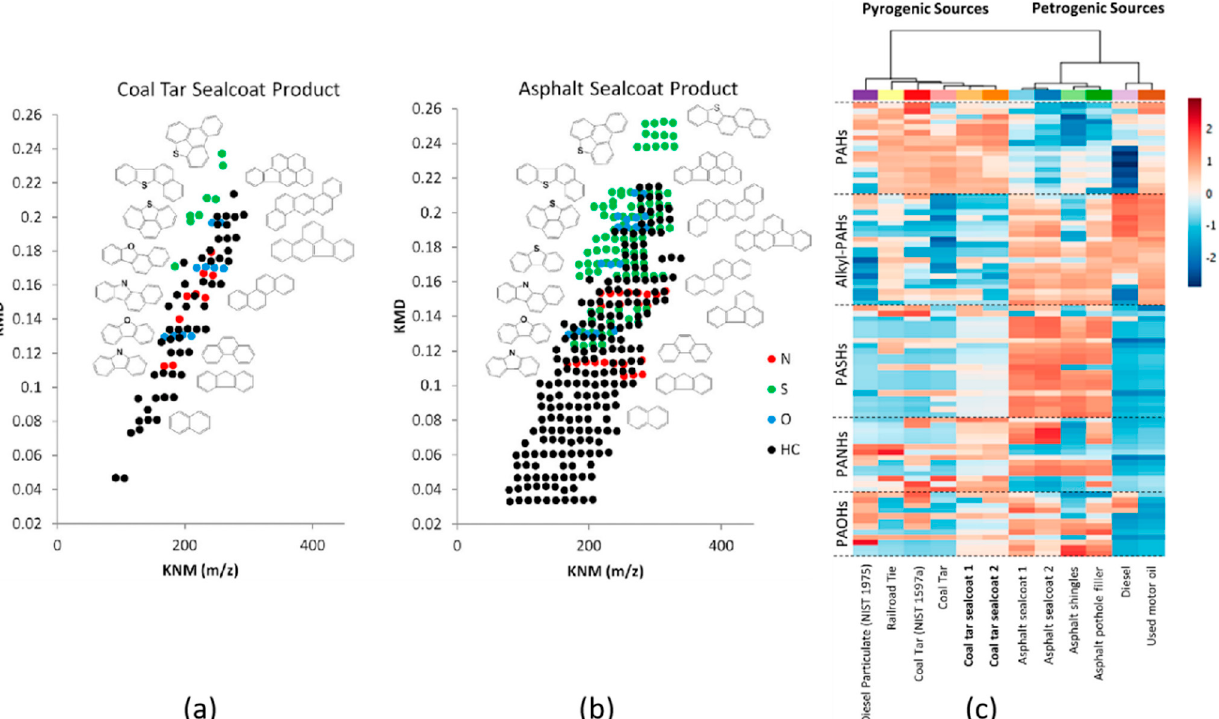
Figure 3. Kendrick mass defect (KMD) plots of ( a ) a coal tar sealcoat product, and ( b ) an asphalt sealcoat product. ( c ) Two-dimensional hierarchical cluster analysis with heat map plot of various environmental PAH sources. The colors red and blue represent the most intense and least intense relative abundance values (log scale). The relative abundances in the heat map plot are presented as an average of three replicates. Reproduced from Bowman et al. [84] with permission. Copyright 2019 American Chemical Society.